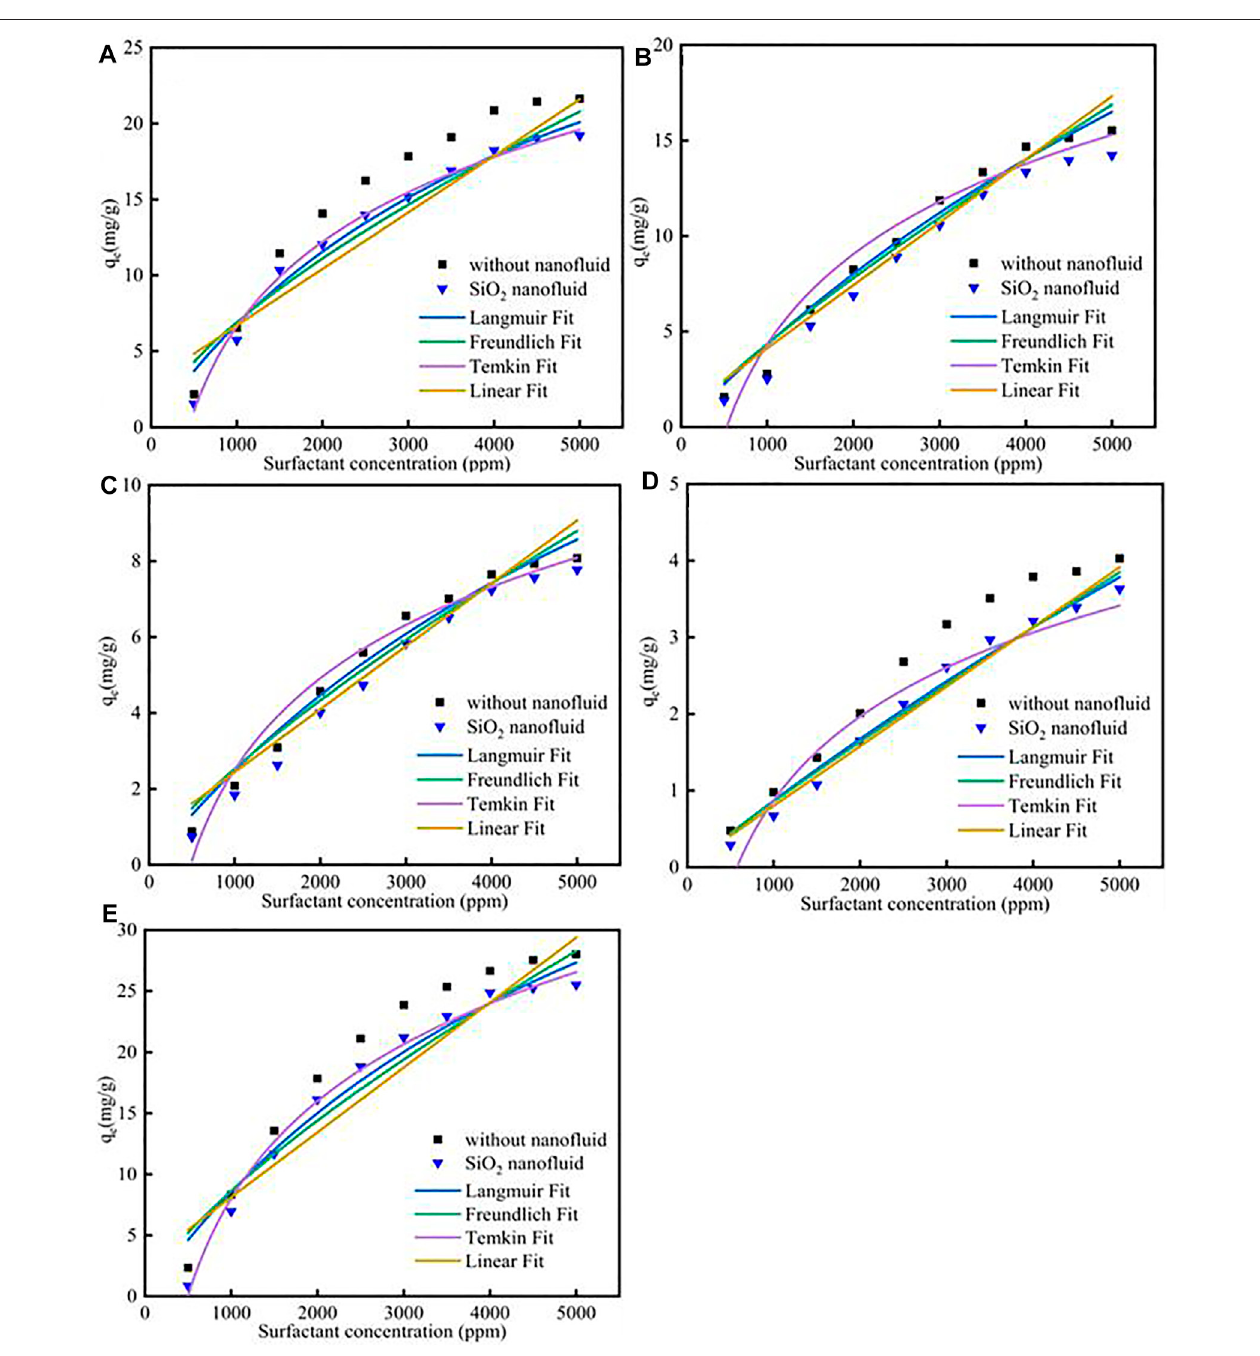
FIGURE4| Differentsurfactants (A) CTAB, (B) SDS, (C) TX-100, (D) sophorolipid, (E) rhamnolipidwithSiO 2 nanoparticlesadsorption oncarbonaterock at298 K.